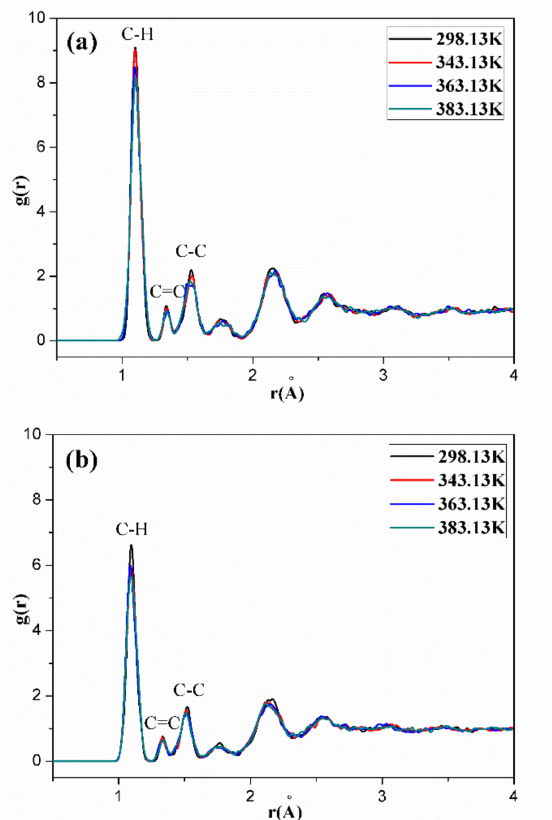
Figure 11. The molecule-molecule radial distribution functions (RDFs) of carbon atoms (C–C) in the NBR model in the uncompressed ( a ) and compressed ( b ) states.